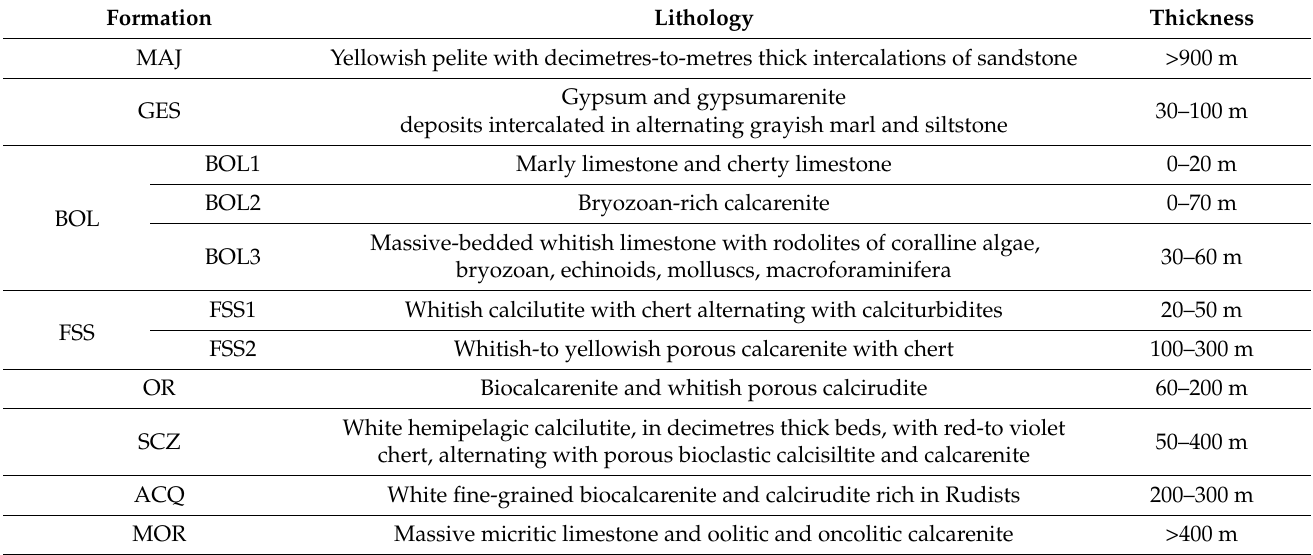
Table 1. Characteristics of the formations that constitute the Majella unit